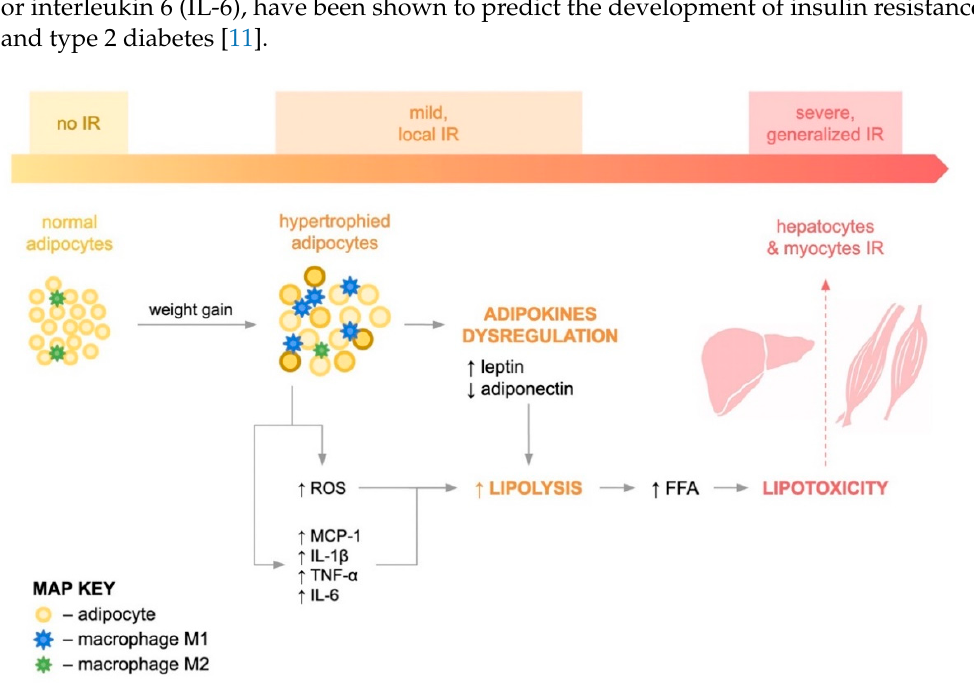
Figure 2. IR pathophysiology.